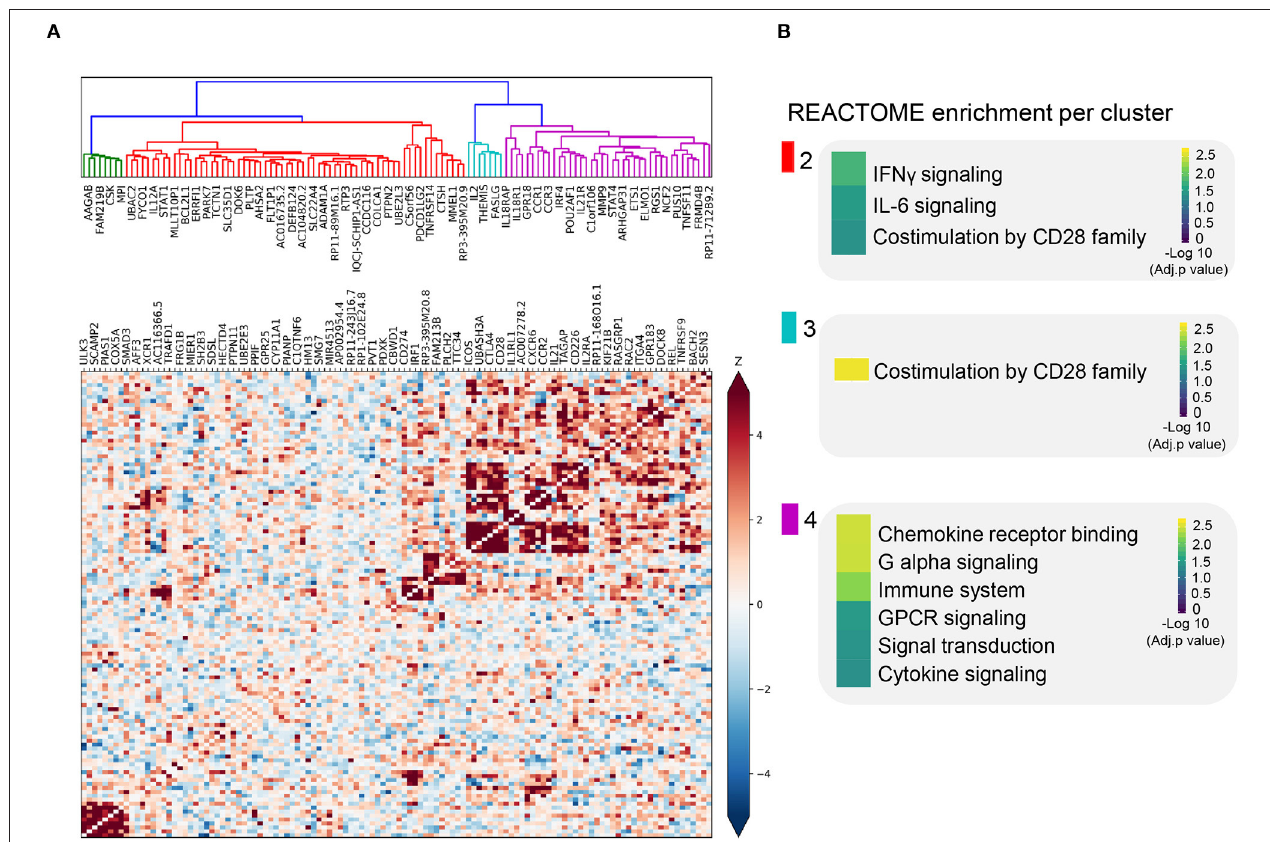
FIGURE 2 | Co-expression pattern of cis -eQTL prioritized genes. (A) Heatmap showing the Spearman correlations between gene expression patterns of each prioritized gene. Blue squares indicate a negative correlation. Red squares indicate a positive correlation. Both are shaded on a gradient scale according to the Z score of the correlation. A dendrogram computed with Ward distances between the correlations is shown on top of the heatmap. Branches of the dendrogram are colored differently to mark separate clusters. (B) Results of the REACTOME gene set enrichment analysis of the genes belonging to each of the clusters identified in (A) . Color key denotes the significance (-log 10 multiple testing adjusted p -value) of each biological